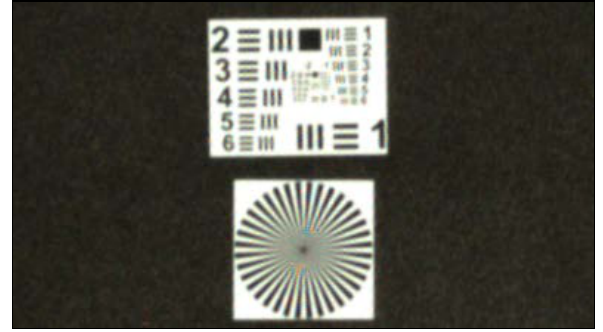
Figure 7: Resolution test charts (original resolution) The post-processing of the raw images was done under consideration of the parameters for DSNU and PRNU (section 3.2) in bilinear debayering mode.